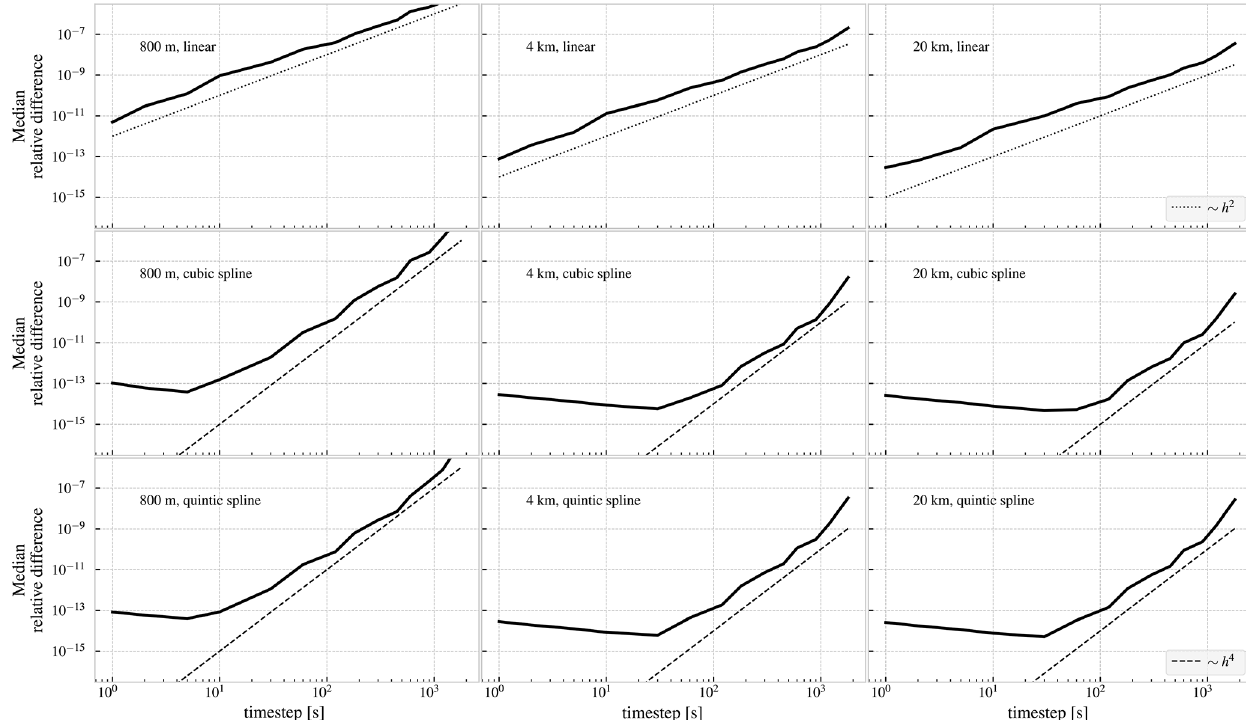
Figure A3. Median relative difference (Eqs. A2a and A2b) between two fourth-order Runge–Kutta solutions, obtained with different time steps h i and h i + 1 , using the list of time steps in Table